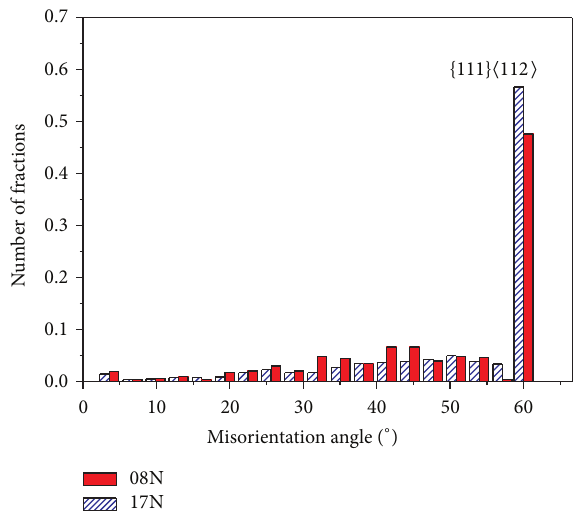
Figure 11: Effect of N content on grain growth